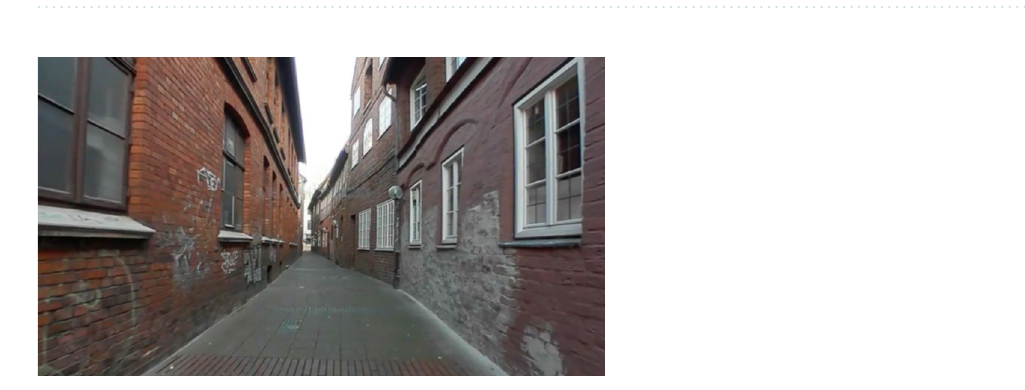
Figure 1. Forest environment.